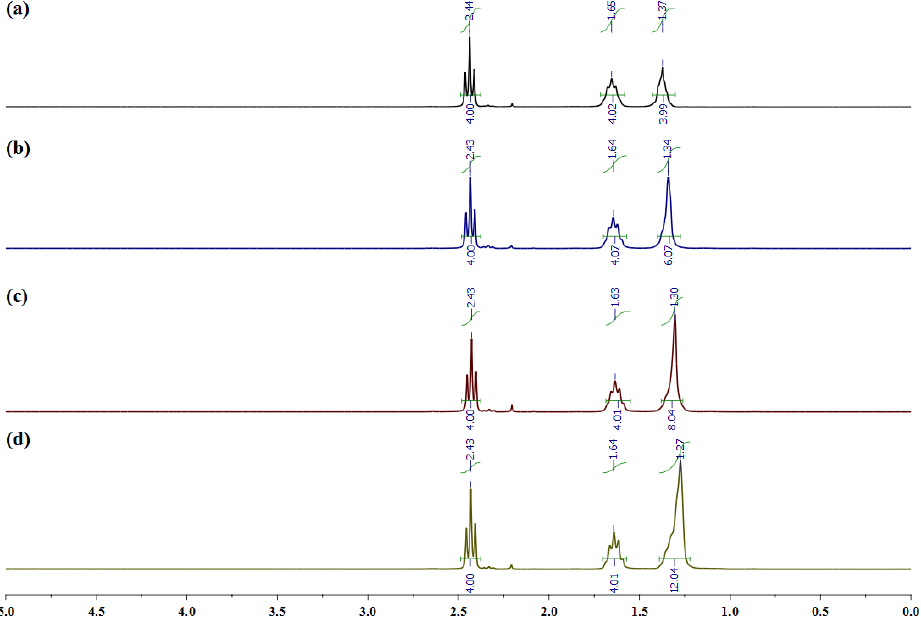
Figure 3. Overlay of GPC chromatograms of PSA synthesized by melt condensation of sebacic acid in the presence of 0.25 (red), 0.5 (blue), 1.0 (green) and 5.0 (black) (X axis is elusion time in minutes, Y axis is the intensity of absorption which translates to content).